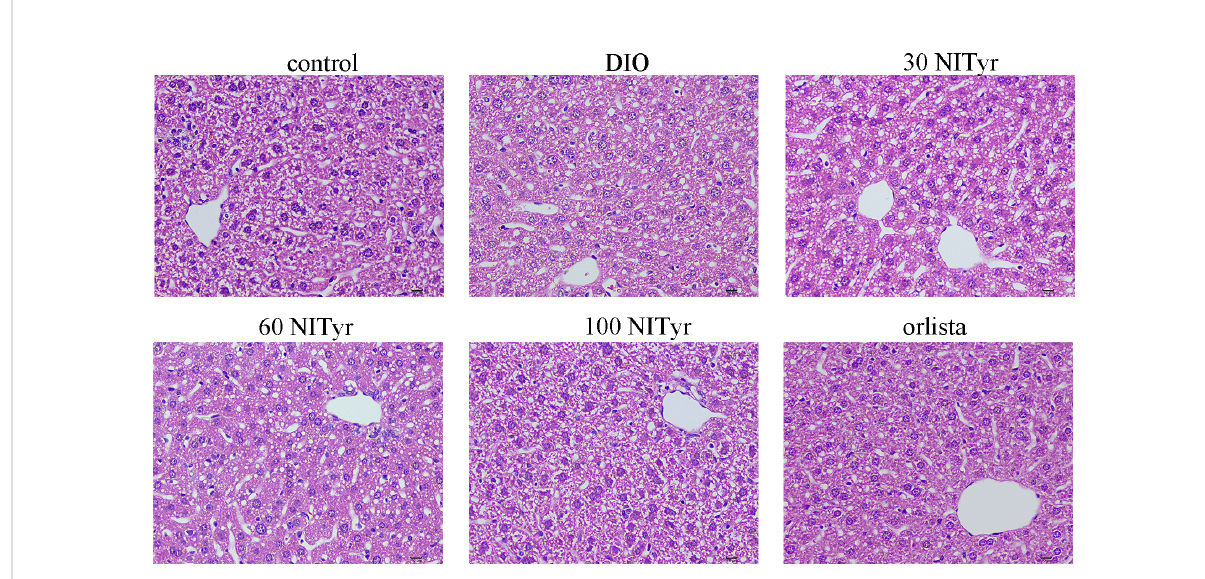
FIGURE 5 The liver tissue of mice stained by the H&E method. scar bar = 10 µm. The control or DIO group was treated with Poloxamer 188 aqueous solution. 30 NITyr, 60 NITyr, 100 NITyr and Orlistat were treated with 30 mg/kg NITyr, 60 mg/kg NITyr, 100 mg/kg NITyr, 100 mg/kg Orlistat, respectively.